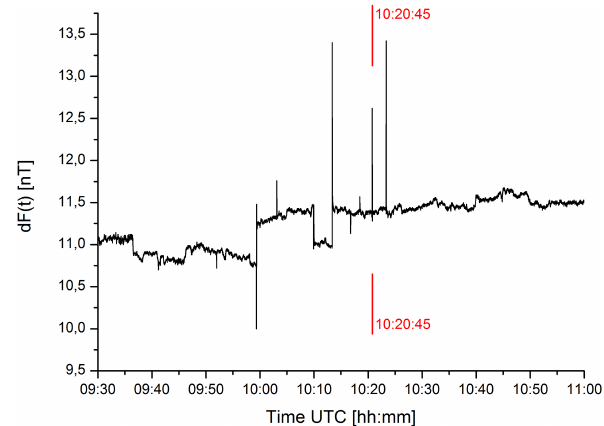
Figure 4. Change in the geomagnetic field d F(t) recorded during the measurements on 15 January 2013, at the beginning of the sec- ond part of the snowstorm on